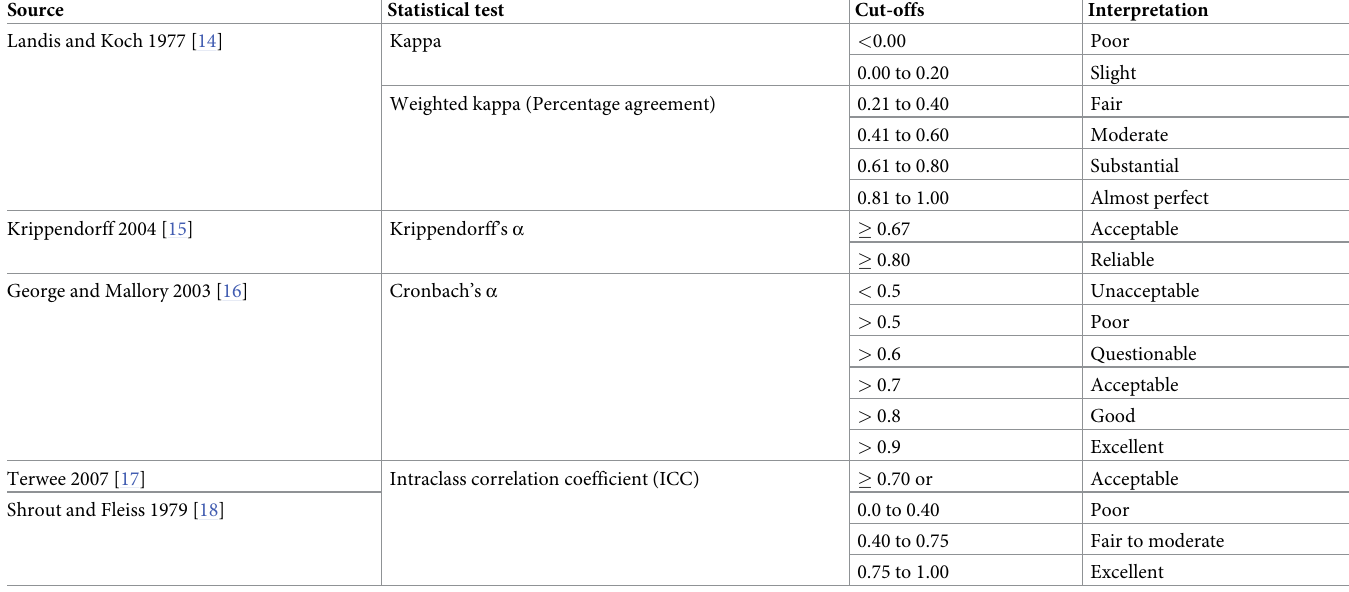
Table 1. Cut-offs for strength of